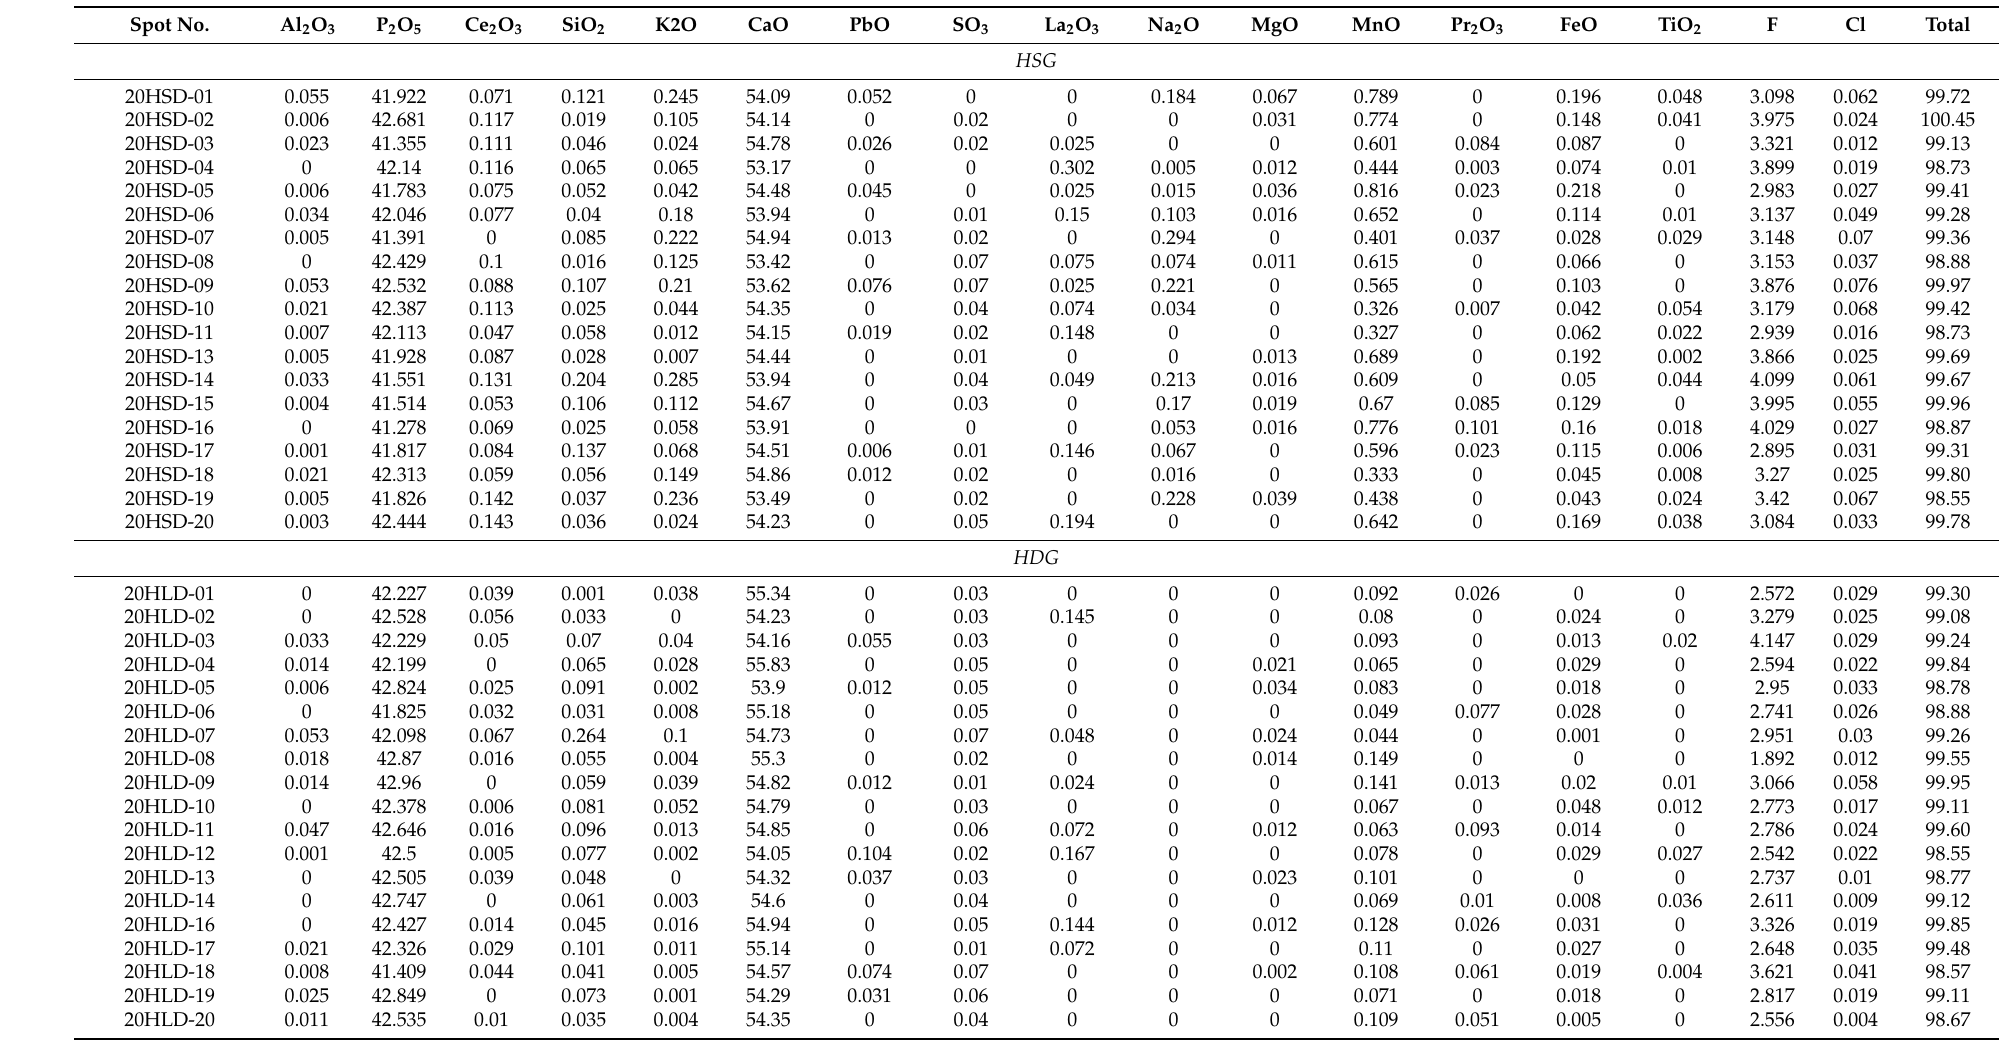
Table 4. Major element compositions (10 − 2 ) of apatite grains from the HSG and HDG of the KDSZ. Spot